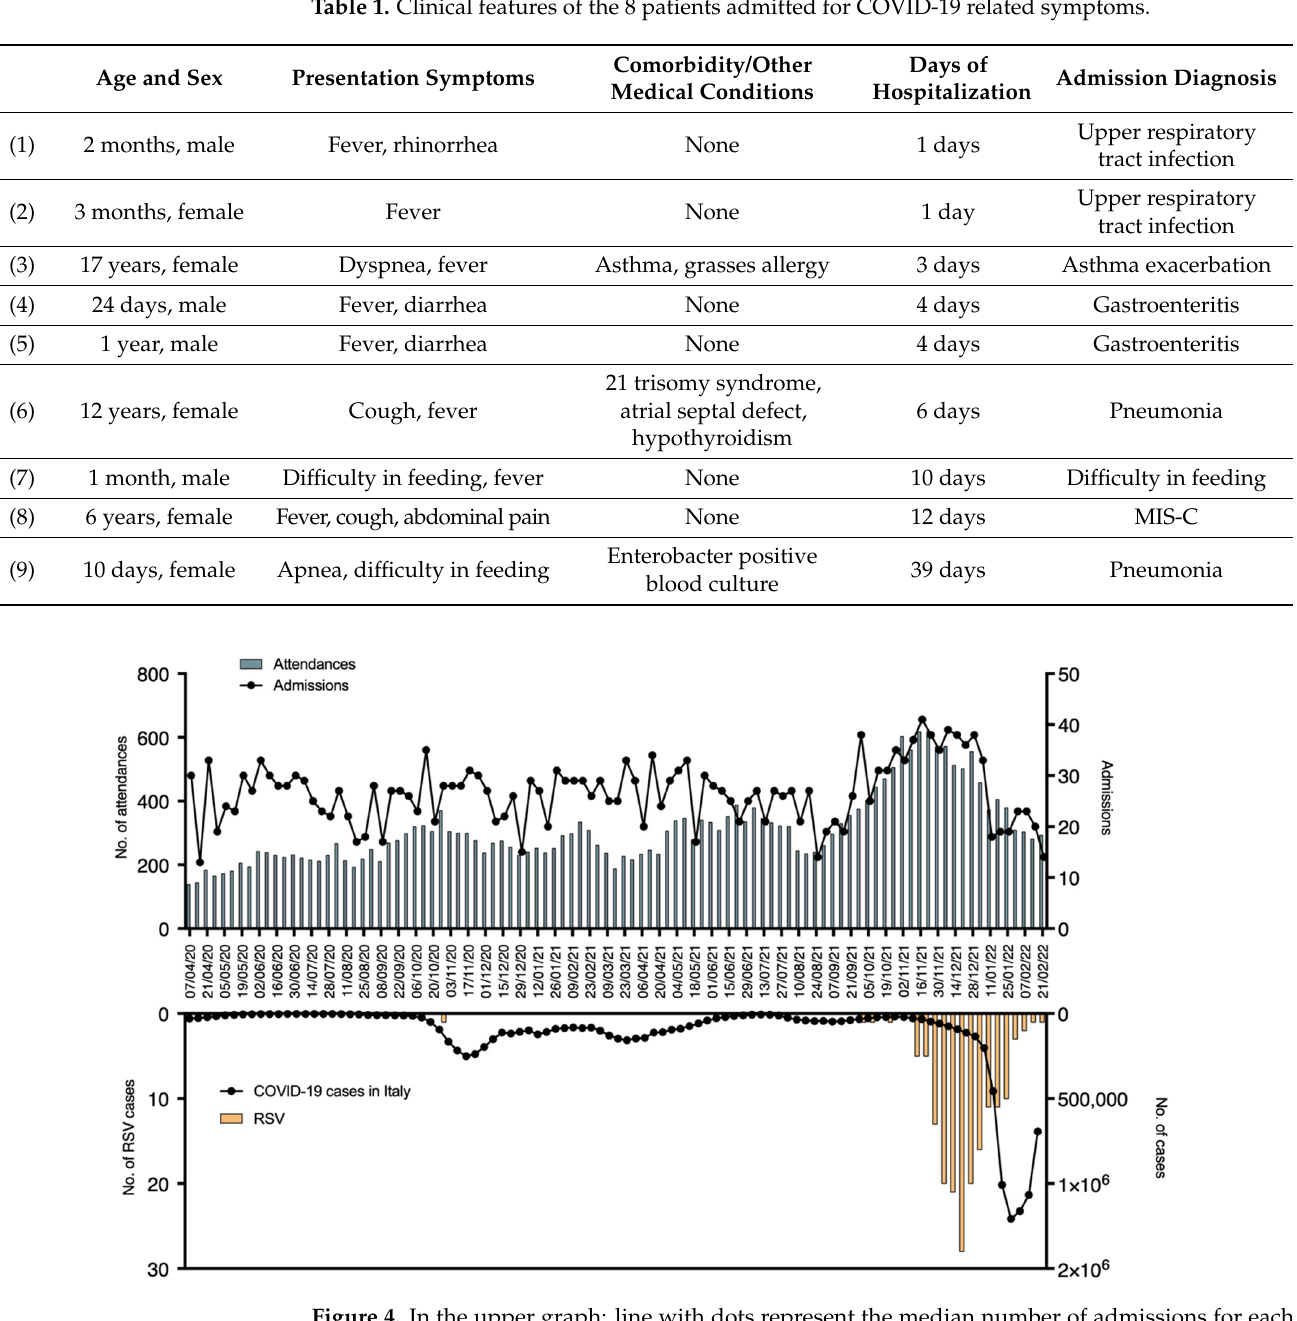
Figure 4. In the upper graph: line with dots represent the median number of admissions for each week and green bars the median number of attendances to the ED for each week. In the inferior graph: line with dots represents the median number of COVID-19 cases for each week in Italy and yellow bars the median number of RSV infections for each week.